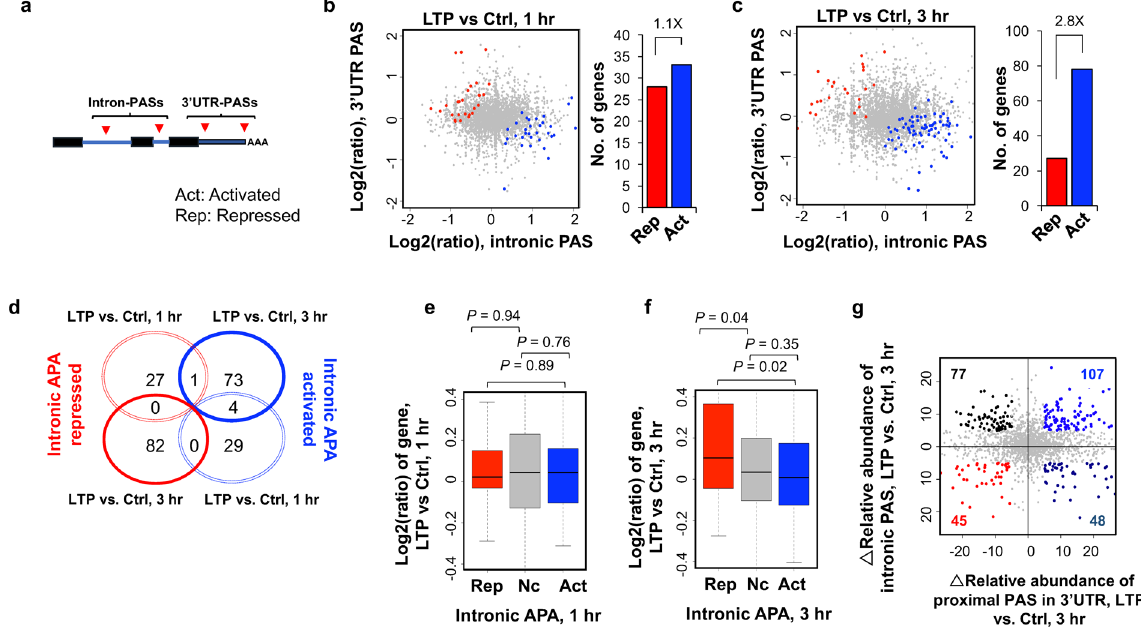
Figure 4. Regulation of intronic APA after LTP induction. ( a ) Schematic of intronic APA analysis. Intronic PASs were compared with 3 ′ UTR-PASs. ( b ) and ( c ) Left, scatterplot comparing expression change (LTP vs. control) of intronic PASs (x-axis) and 3 ′ UTR PASs (y-axis). Genes with significantly activated intronic PAS usage are shown in blue (Act) and those with significantly repressed intronic PAS usage in red (Rep) (p < 0.05, DEXSeq and relative abundance change > 5%). Grey dots represent genes without significant regulation (Nc). Right, bar graph showing the number of genes with activated or repressed intronic APA. ( d ) Venn diagram comparing genes with CDS-APA regulation at 1 hr post LTP and 3 hr post LTP. Genes correspond to those in ( b ) and ( c ). ( e ) and ( f ), Box plot showing the log 2 ratio (LTP/Ctrl) of genes with intronic PAS activation or intronic PAS repression, 1 hr ( e ) or 3 hr ( f ) post LTP induction. Genes with significant intronic APA regulation are those from ( b ) or ( c ). P-values (Wilcoxon rank sum test) indicate the difference between groups. ( g ) Scatterplot comparing 3 ′ UTR APA regulation (x-axis) and intronic APA regulation (y-axis) at 3 hr post LTP induction. Δ relative abundance for 3 ′ UTR APA is based on the two 3 ′ UTR PASs with most reads, as in Fig. 2, and Δ relative abundance for intronic APA is based on all intronic PAS reads vs. all 3 ′ UTR PAS reads. Genes with intronic APA and/or 3 ′ UTR APA change ( > 5% relative abundance) are highlighted with different colors based on the type of